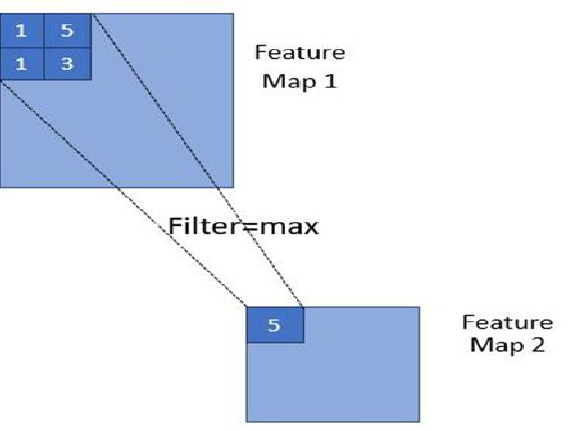
Figure 7. Example of a max-pooling layer which takes feature maps of previous layers as input and generates its own reduce sized feature maps.